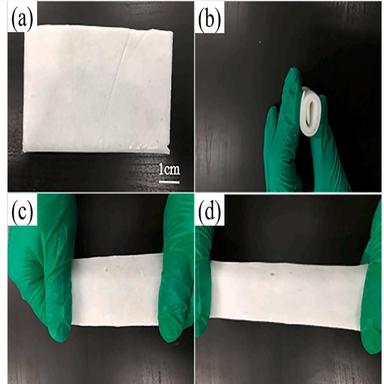
(a) Photograph of the EHS/UVPUA composite, (b) photograph of flexibility display of EHS/UVPUA, and (c, d) photographs of toughness display of EHS/ UVPUA composites . Reproduced with the permission of the American Chemical Society.